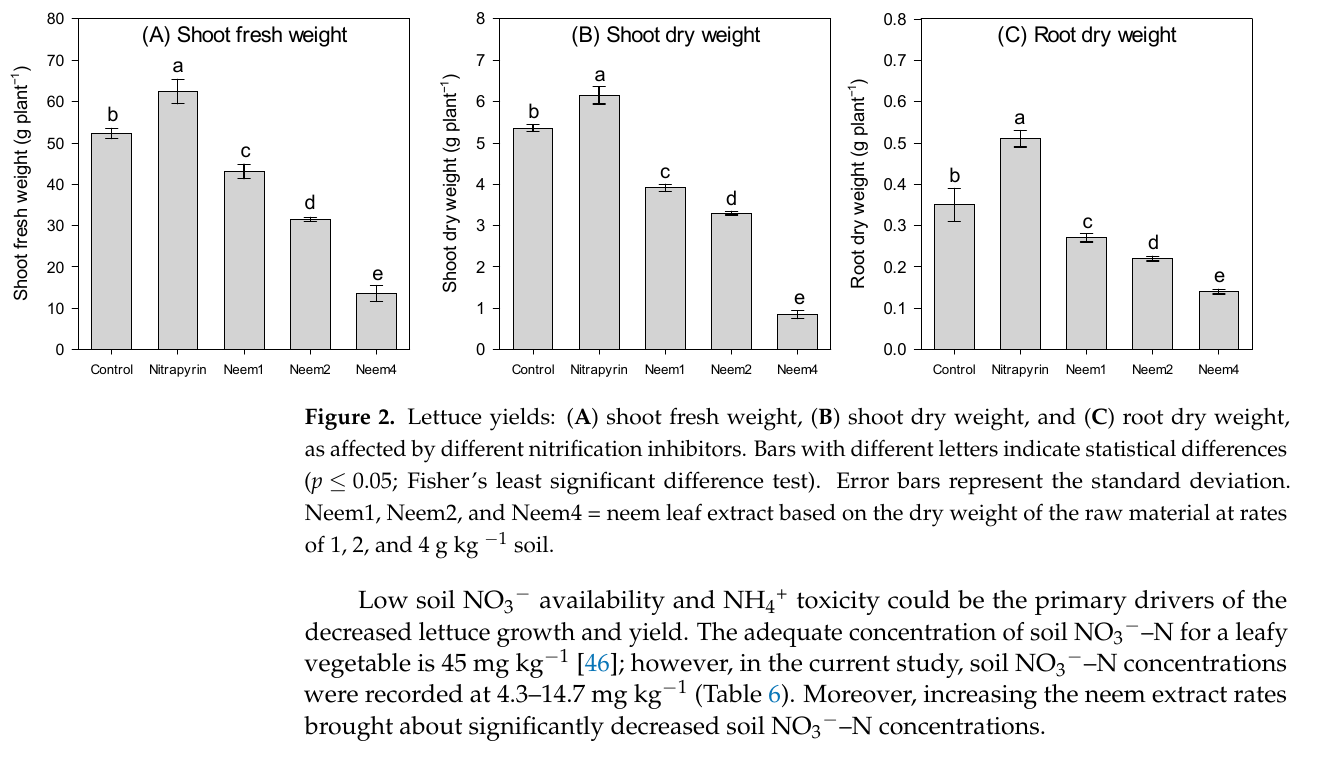
Figure 1. Lettuce growth: ( A ) height; ( B ) canopy size; and ( C ) leaf number as affected by different nitrification inhibitors. The table accompanying each sub-figure shows the comparisons of the effects of nitrification inhibitors at each time interval (days after lettuce planting). Similar letters within each time interval are not significantly different ( p ≤ 0.05; Fisher’s least significant difference test). Vertical bars represent standard deviation. Neem1, Neem2, and Neem4 = neem leaf extract based on the dry weight of the raw material at rates of 1, 2, and 4 g kg – 1 soil. Table 6. Soil ammonium and nitrate nitrogen concentrations at the lettuce harvest as affected by different nitrification inhibitors.